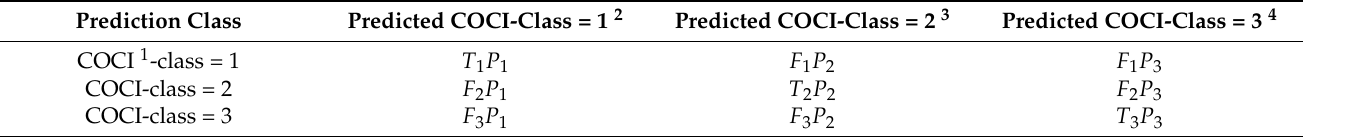
Table 2. The confusion